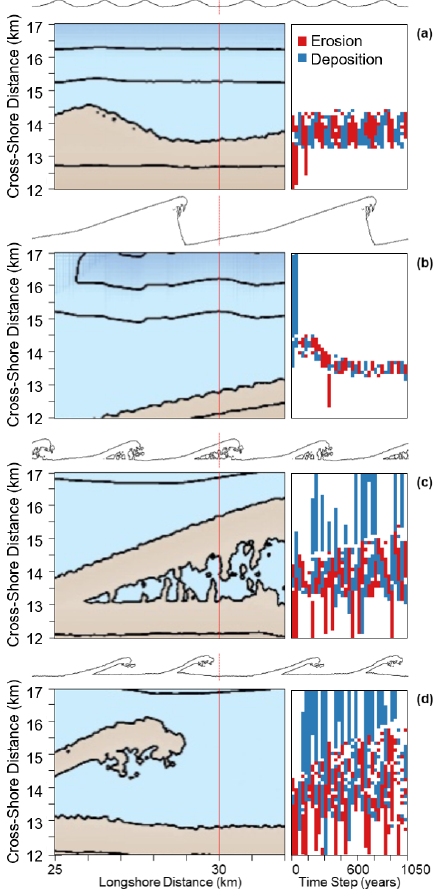
Figure 15. Shoreline morphologies (left) and volume stacks (right) for four simulations where the wave climate is defined by (a) A = 0.5 and U = 0.55, (b) A = 0.6 and U = 0.6, (c) A = 0.7 and U = 0.65, and (d) A = 0.8 and U = 0.7. The red line marks the cross-shore transect where the change in volume at 30-year time intervals is recorded.